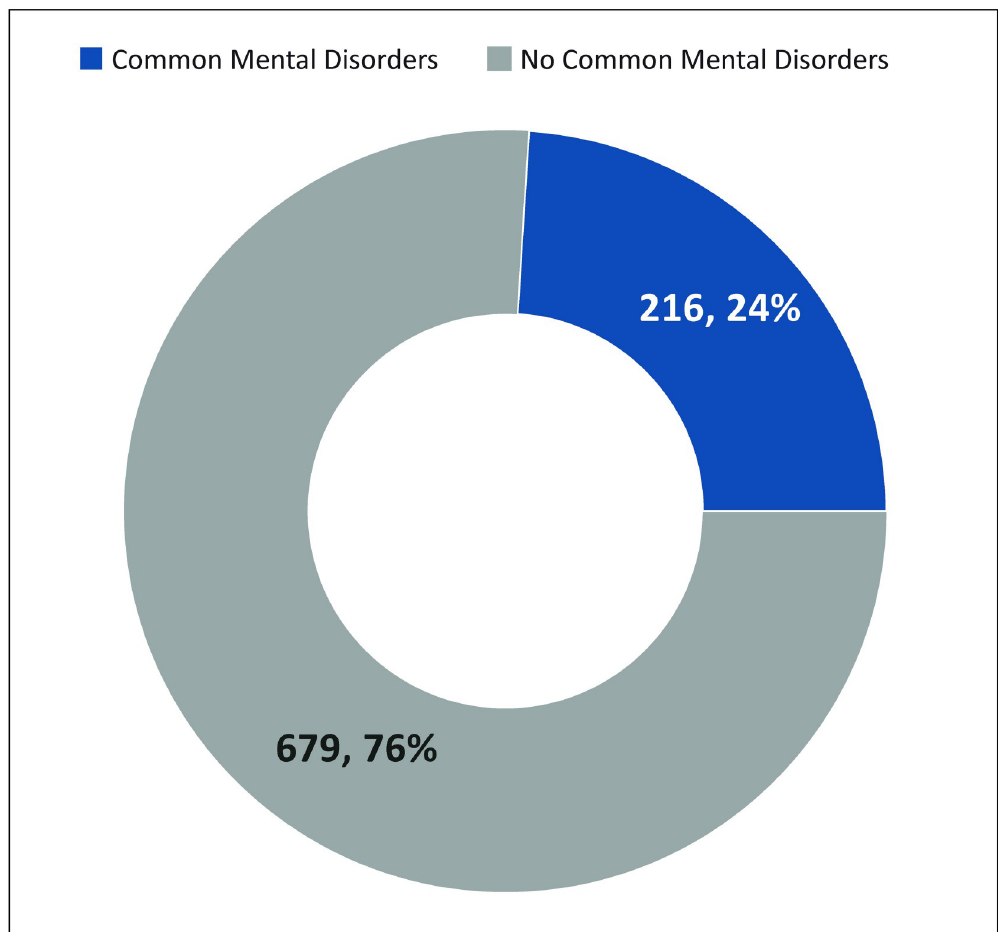
Fig 3. Prevalence of common mental